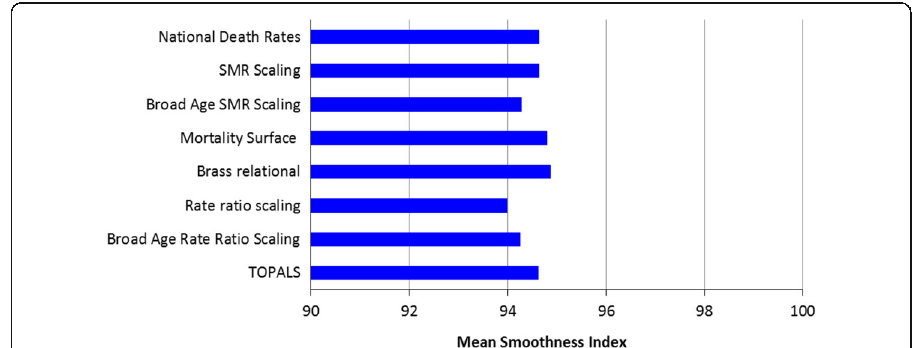
Fig. 2 Mean smoothness of forecast mortality rate age profiles across the 2006 – 11 and 2011 – 2016 periods across all Australian regions. Note: Mean Smoothness Index values were calculated for each method